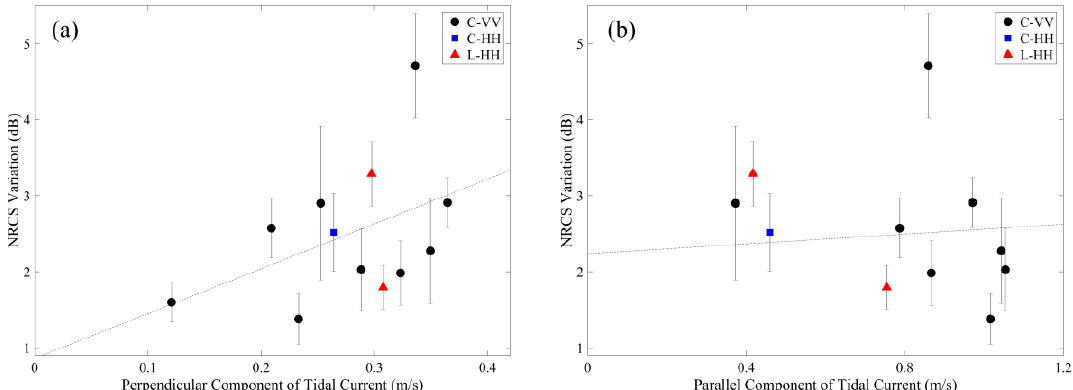
Figure 9. Relationship between the tidal current and variation in the NRCS (dB). NRCS variations in tidal channel signatures as a function of magnitude of ( a ) perpendicular and ( b ) parallel components of the tidal current (m/s).